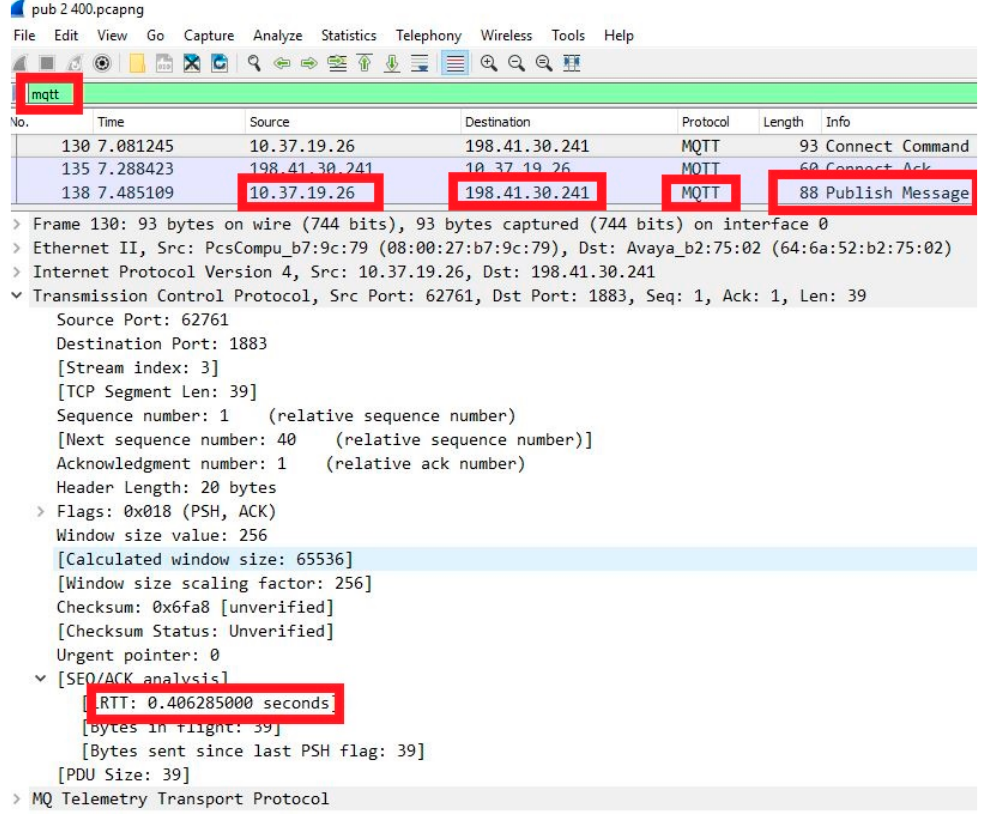
Figure 22. NCC under communication delay for case Bb against case Ac. 6.2.3. Case Bc: Communication Delay ≥ 500 ms The communication system operates to the extent that delay does not affect the data transfer severely. In this study, if the communication delay exceeds 500 ms, the communication operation system fails and enters into the no communication mode. In this mode, the MGs are not transferring data to each other and work based on the predefined references. The communication delay implementation is illustrated in Figure 23. As the neutral current reference is fixed by default, the NCC is expected to be worse compared to other cases. The result in Figure 24 indicates the lowest NCC among the studied cases (11 A in average higher than case Ac).